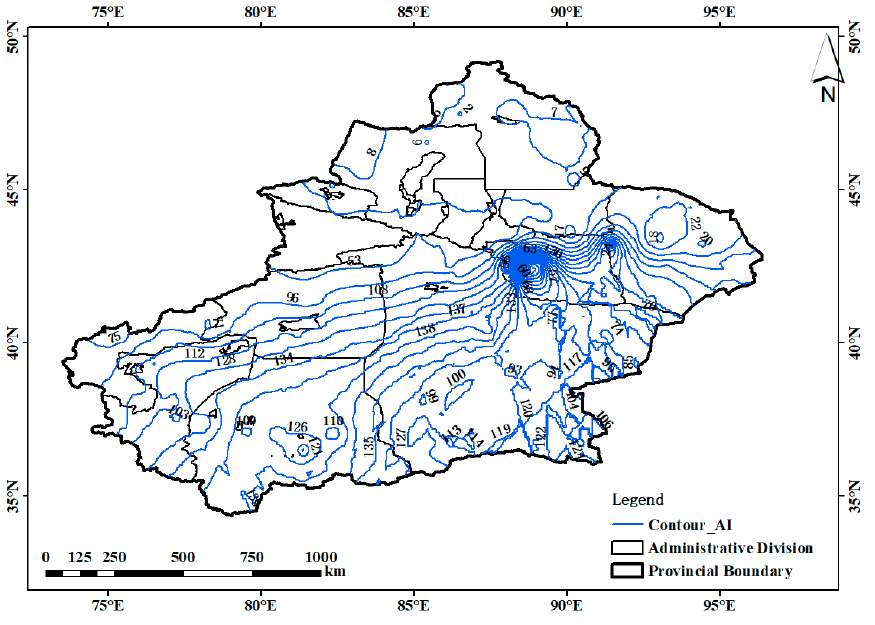
Figure 11. Spatial distribution of the aridity index in Xinjiang.